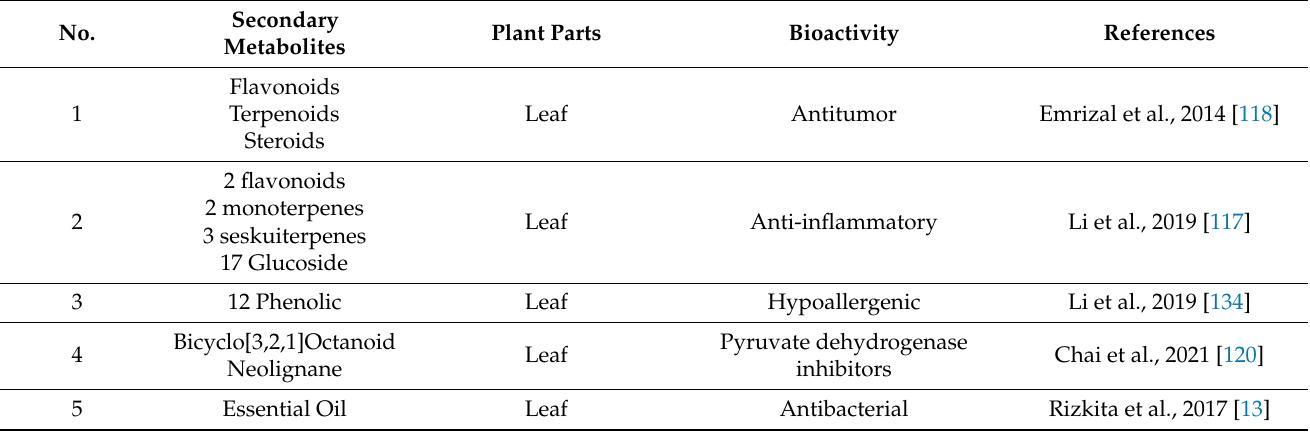
Table 2. Bioactivity of isolated P. crocatum Ruiz and Pav leaves.